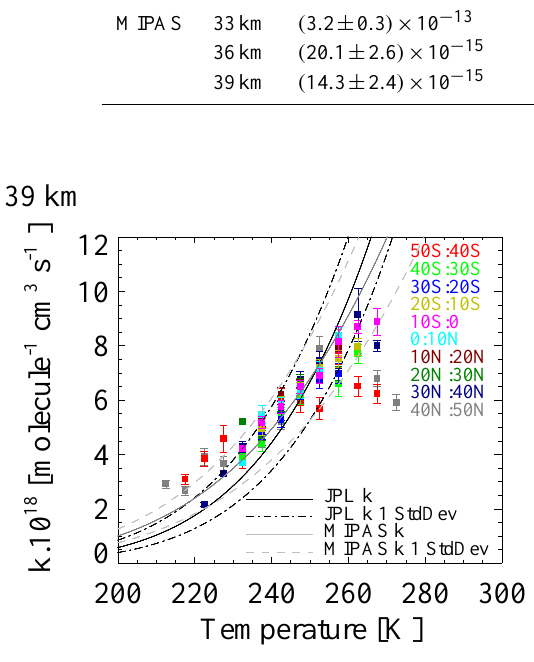
Fig. 9. As in Fig. 7 but at Fig. 8. As in Fig. 6 but at 39 km.